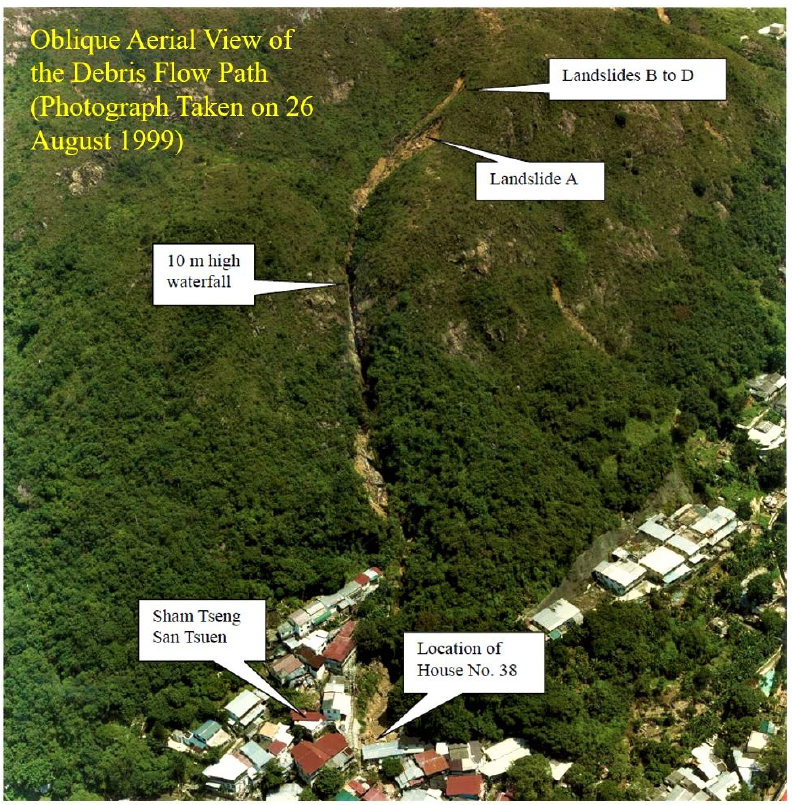
Figure 7. General view of the landslide location. (Provided by Wilson et al. (2005)